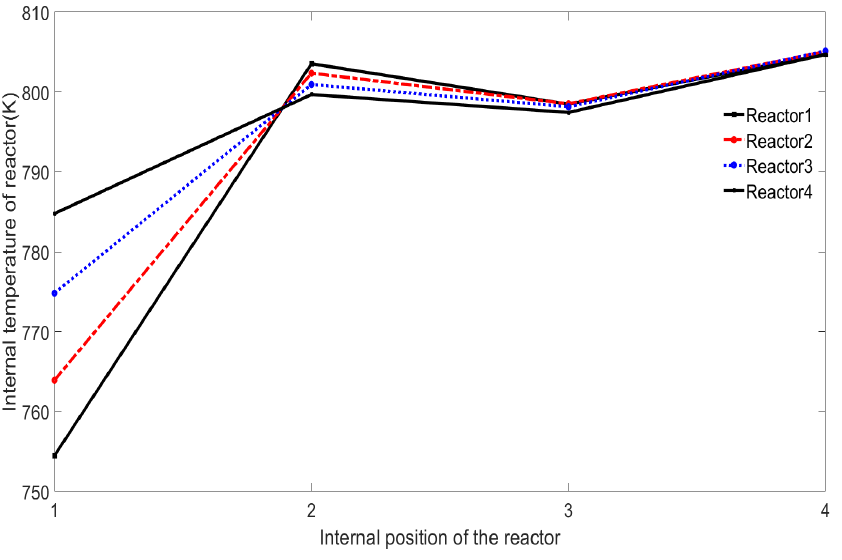
Figure 7. Changes of 34-component lumped at the outlet of each reactor.